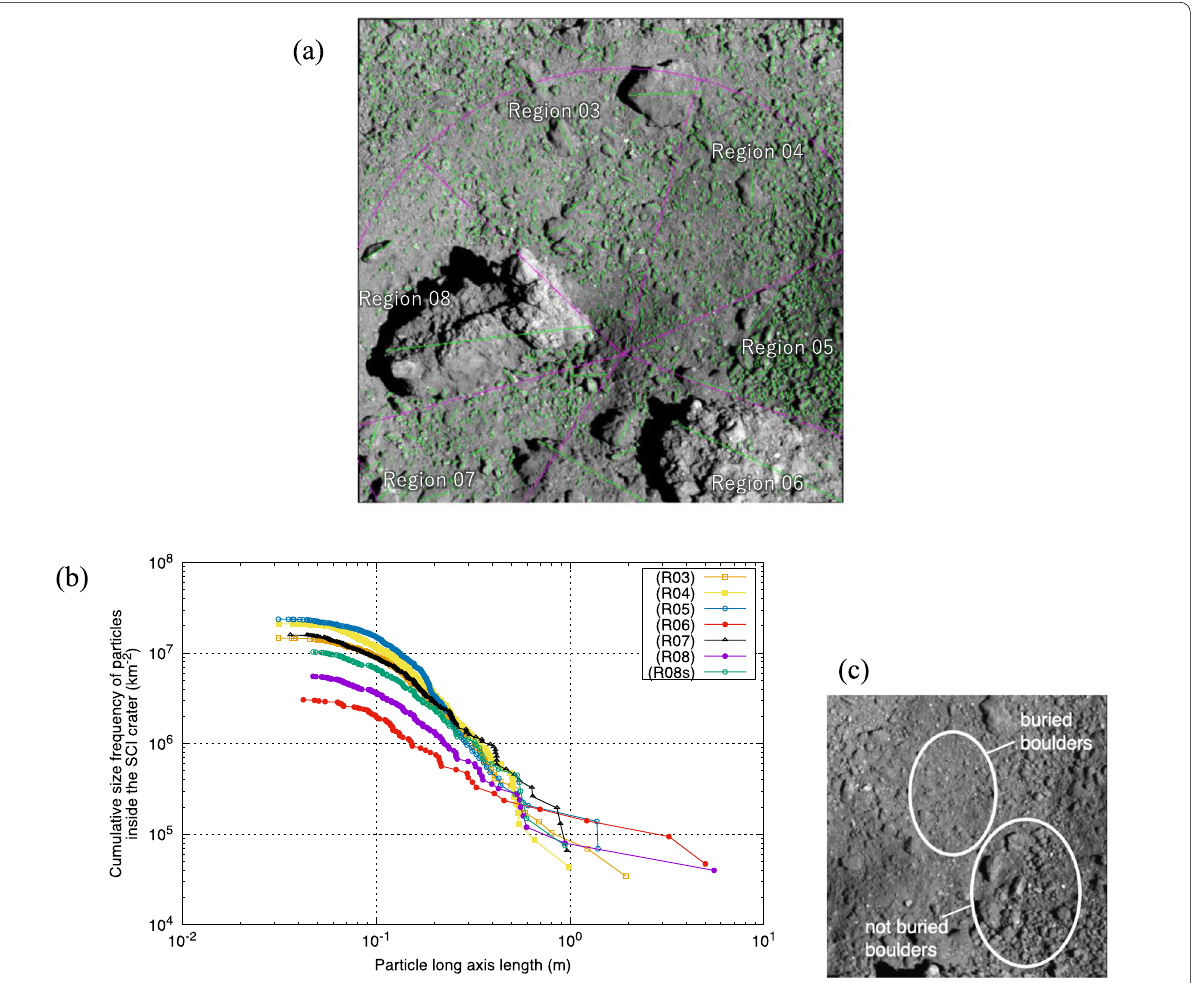
Fig. 3 a High-resolution image of the SCI crater interior taken by ONC-T (hyb2_onc_20190613_020224_tvf_l2c.fit). The crater outline is drawn by a purple arc, and the crater interior is divided into 6 azimuthal segments by six purple lines drawn from the center radially. Each region is named to be Region 03, 04, 05, 06, 07, and 08 clockwise. b Variation of cumulative size frequency distributions of particles inside the SCI crater. c Enlarged photo of the west side of Region 04 and Region